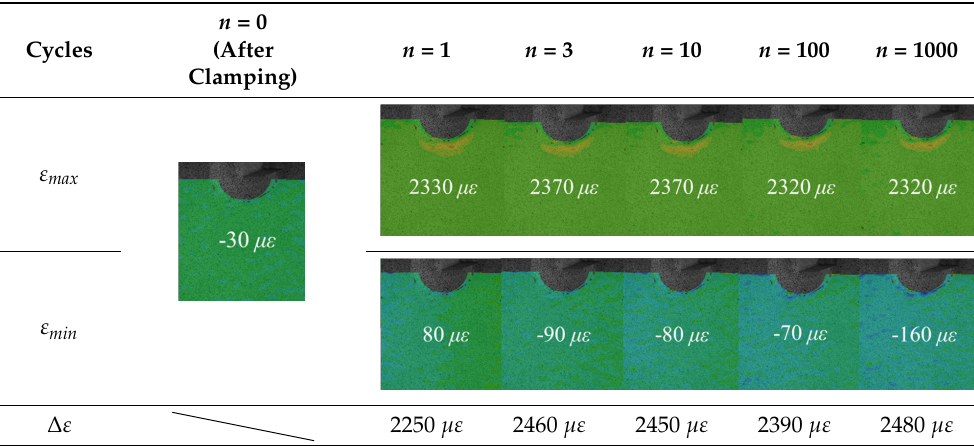
Table 2. Strain distribution measured by the proposed method (Specimen